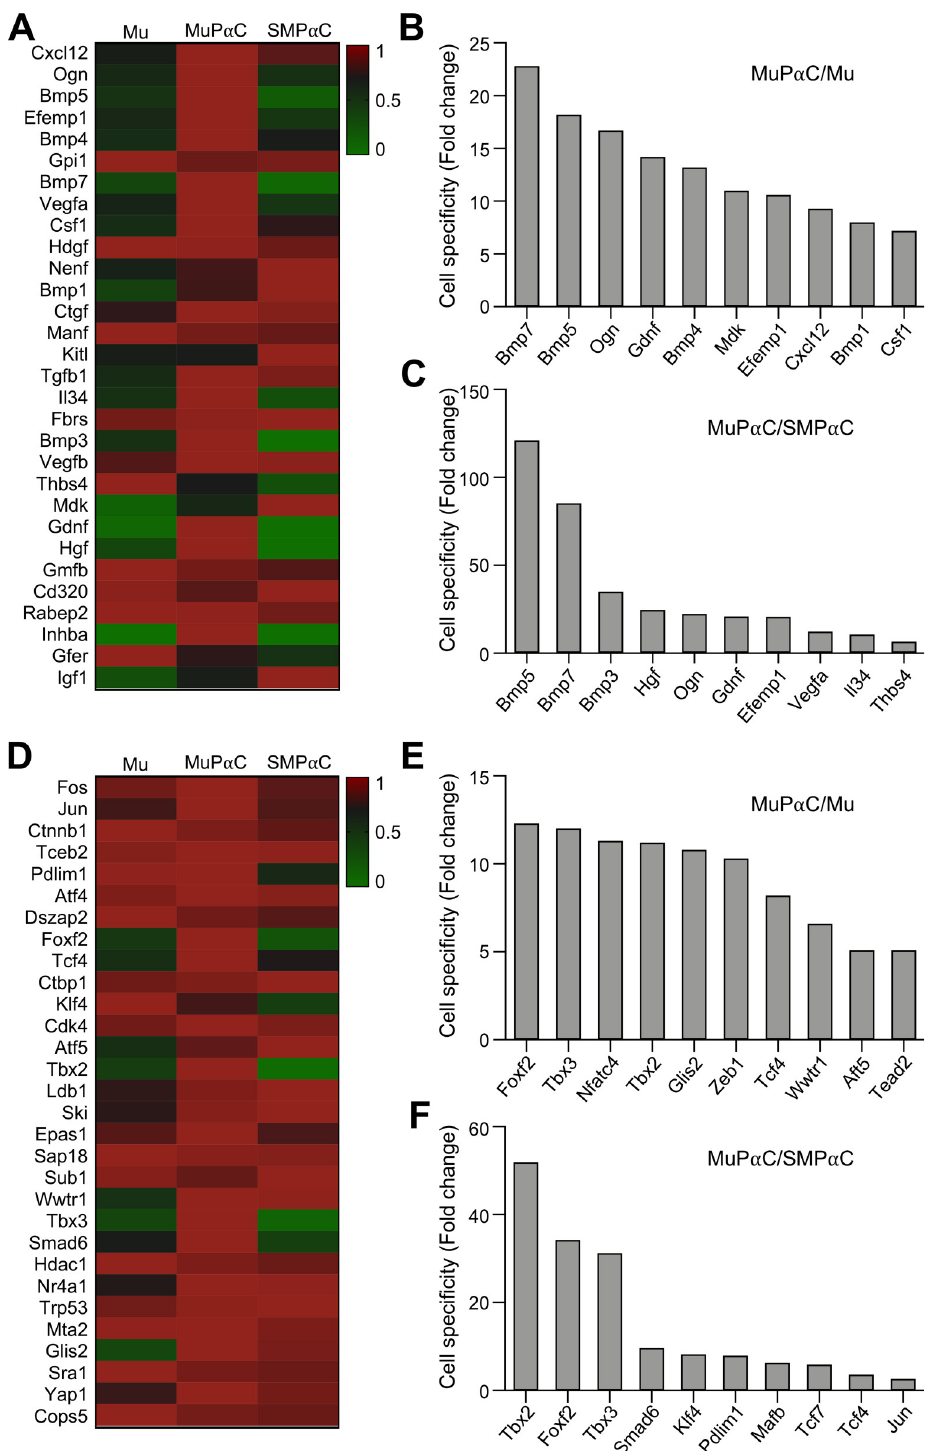
Fig 4. Identification of the growth factors and transcription factors predominantly expressed in colonic MuP α C. A : A heat map of the growth factors enriched in MuP α C compared to mucosal tissue (Mu) and smooth muscle PDGFR α + cells (SMP α C). B : MuP α C-specific growth factors compared to Mu. C : MuP α C-specific growth factors compared to SMP α C. Sorted by MuP α C/Mu, cut off 10 fold MuP α C in MuP α C/Mu; sorted by MuP α C/SMP α C, cut off 10 fold MuP α C and 0 fold SMP α C in MuP α C/SMP α C. D : A heat map of the transcription factors enriched in